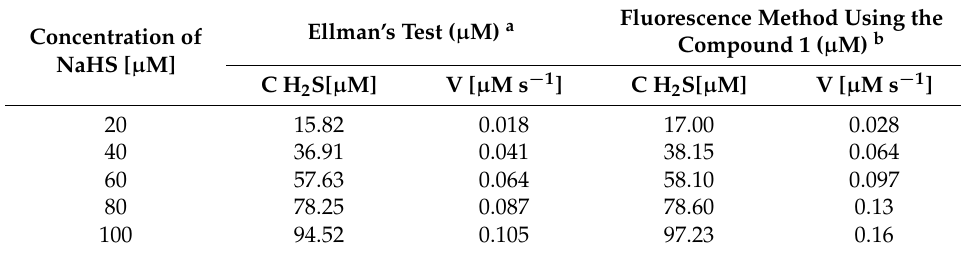
Table 2. Comparison of detection methods for H 2 S.